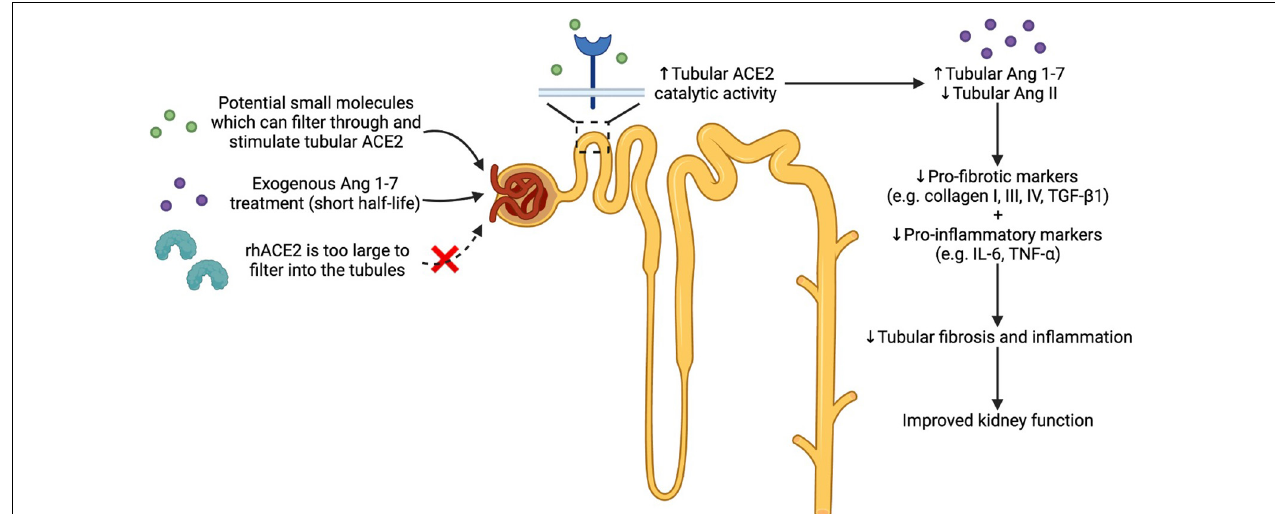
FIGURE 1 | Effects of theoretical use of small molecules which activate the reno-protective arm of the RAAS (ACE2/Ang 1-7/Mas receptor axis). Activating the ACE2/Ang 1-7/Mas receptor axis is one approach in treating diabetic nephropathy where chronic activation of the classical RAAS is observed. ACE2 stimulation using potential small molecules which can filter into the renal tubules can increase the catalytic activity of tubular ACE2. This in turn can enhance the production of Ang 1-7 and degradation of Ang II, thereby reducing renal inflammation and fibrosis, leading to improved kidney function. Ang 1-7-based therapy is another approach in activating the reno-protective arm of the RAAS. However, the short half-life of Ang 1-7 is a major drawback, making it challenging to translate Ang 1-7-based therapy to the clinic. Additionally, large proteins such as rhACE2 cannot reach the renal tubular cells due to the limited capillary